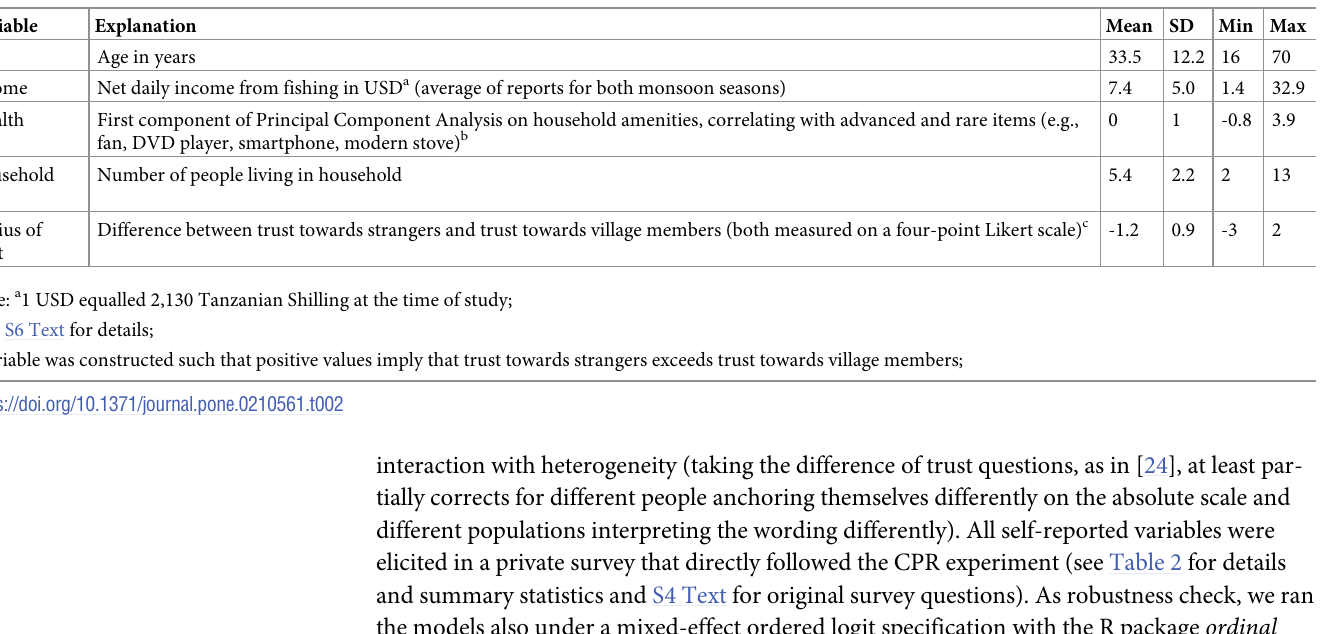
Table 2. Explanation and summary statistics for variables from the survey used in the regressions.